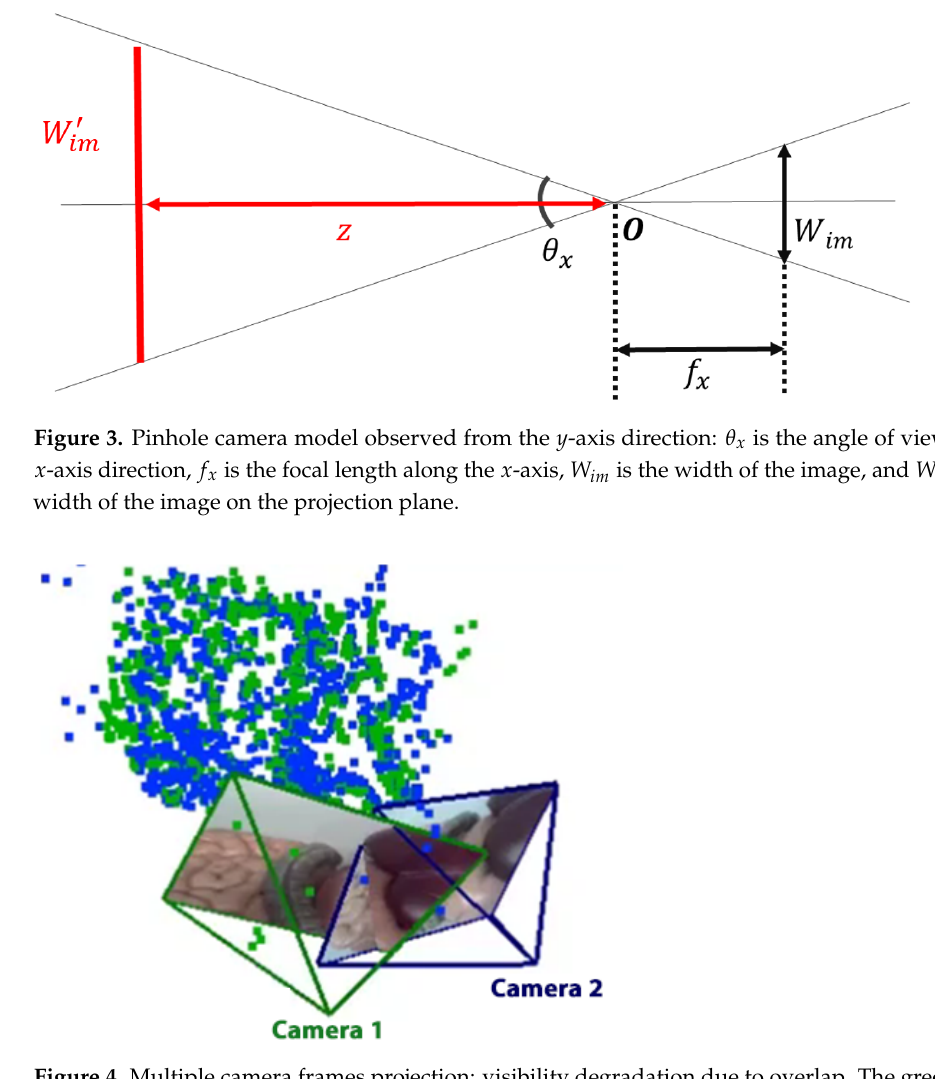
Figure 4. Multiple camera frames projection: visibility degradation due to overlap. The green point cloud is the map of camera 1 while the blue cloud is the transformed map of camera